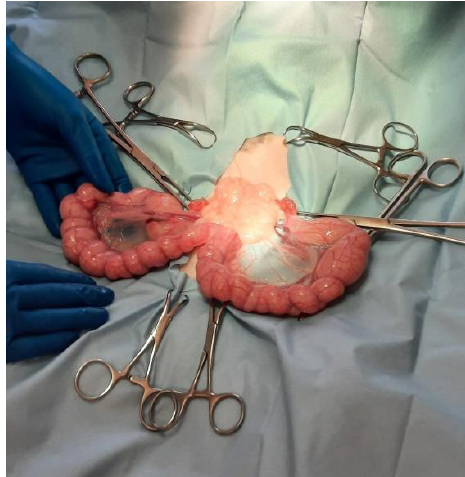
Figure 3. The uterus is externalized.